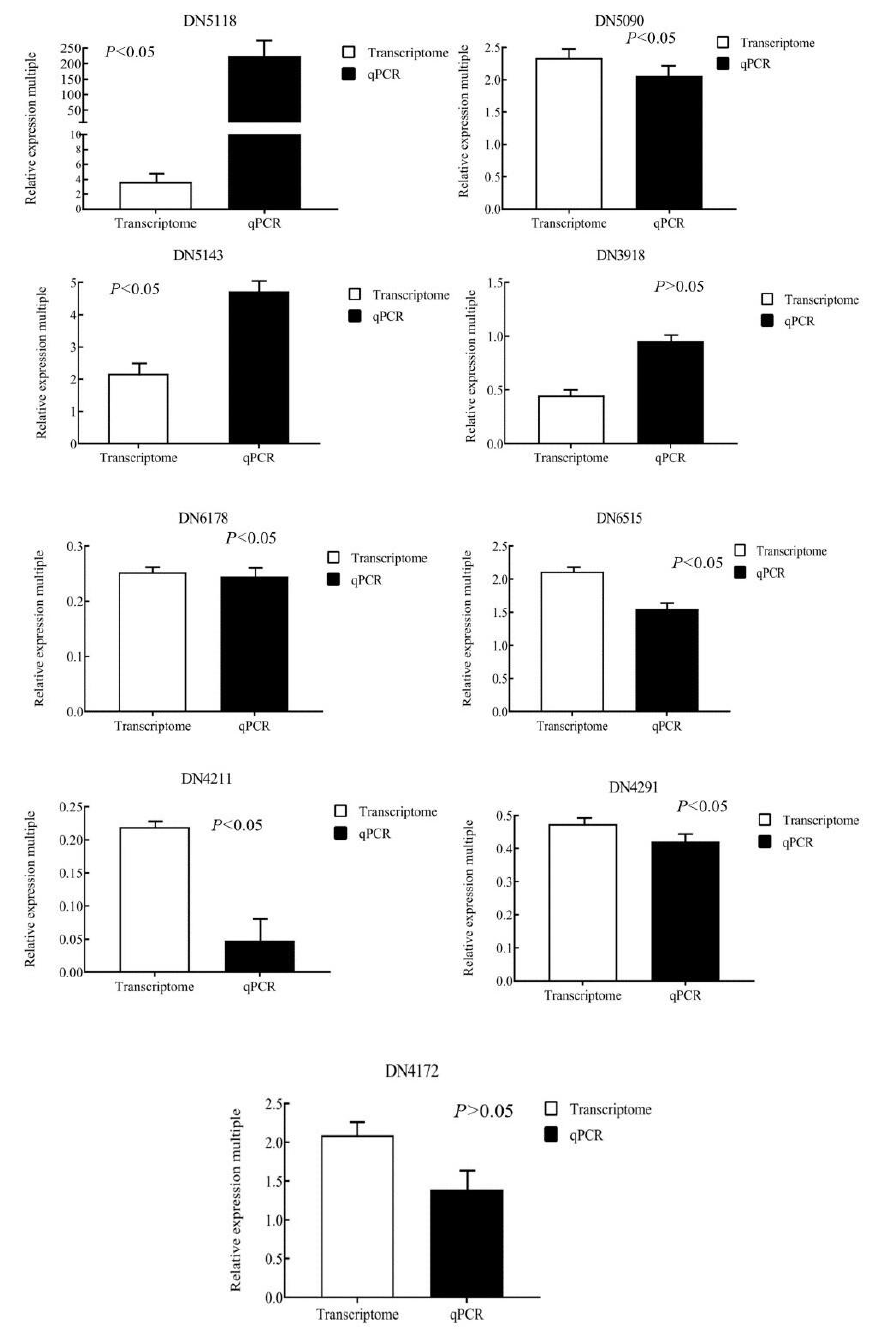
Figure 1. The nine significantly differential expressed genes in U. prolifera under high light intensity (400 µ mol · m − 2 · s − 1 ) were verified by